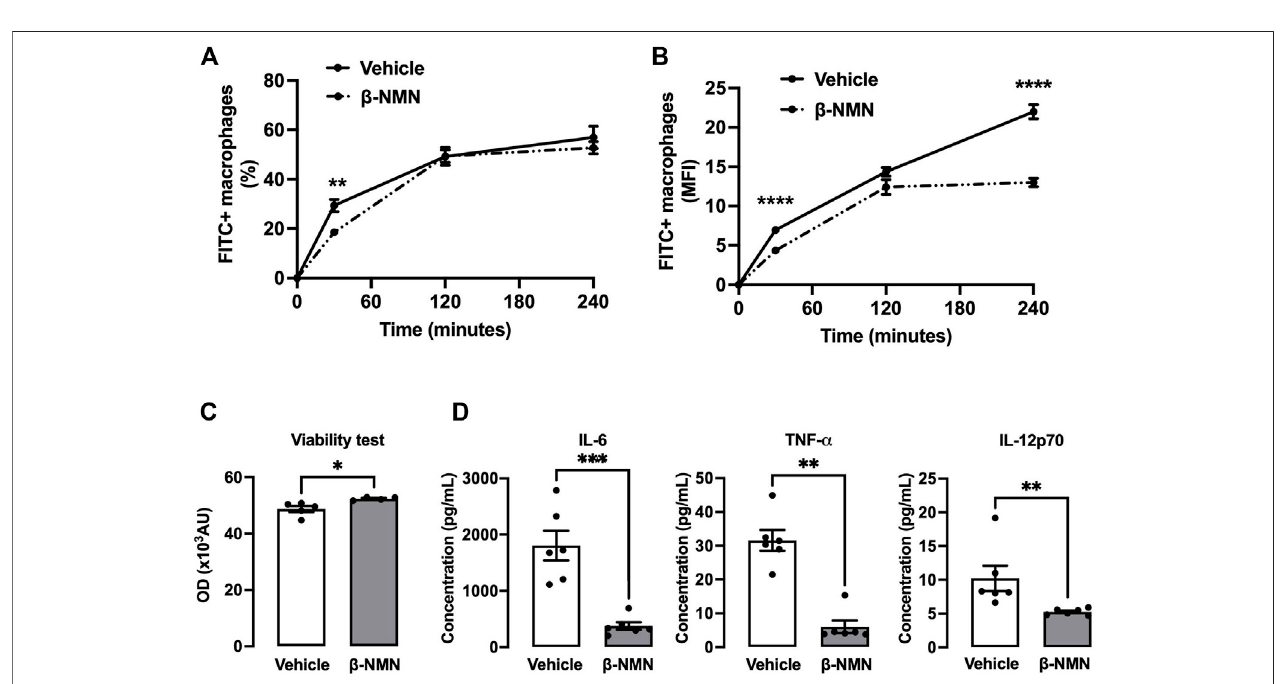
FIGURE 4 | Functional properties of peritoneal macrophages following stimulation with E. coli in the TGC-induced peritonitis mouse model. (A,B) Phagocytosis of peritonealmacrophages.ThreedayspostTGCadministration,macrophagesfromperitoneallavage fl uidwereculturedonplatesandstimulatedwithpH-Rhodo-labeled E.coli .Theproportionofphagocyticmacrophagesat30,120,and240 minwasanalyzedby fl owcytometry.Thequantityofengulfed E.coli wasexpressedas%oftotal macrophages (A) or as the mean of fl uorescence intensity (MFI) (B) . (C,D) Viability and pro-in fl ammatory secretion of peritoneal macrophages. Three days post TGCadministration,macrophageswereco-culturedwith E.coli for24 h. (C) ViabilityofmacrophageswasassessedbytheAlamarBlue ® assayandexpressedasoptical density (OD). (D) Secreted cytokine concentrations (IL-6, TNF α , and IL-12p70) were determined in the cell culture supernatant by fl ow cytometry using a bead-based immunoassay.IL=interleukin;TNF- α =tumornecrosisfactor-alpha.Alldataaremean±SEM;n=4 – 6foreach group;* p < 0.05;** p < 0.01;*** p < 0.001;**** p < 0.0001 vs. vehicle.